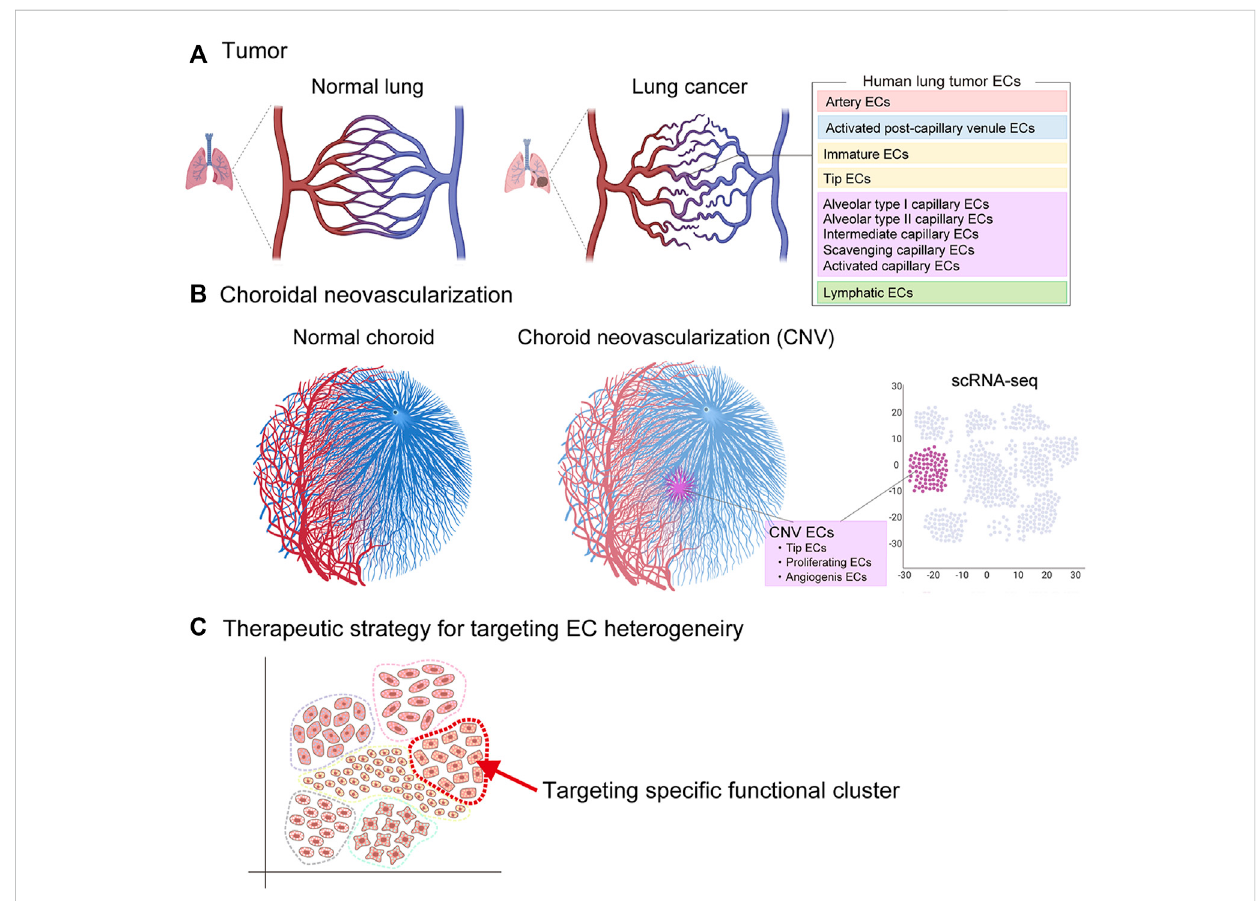
FIGURE 8 Vascular endothelial cell heterogeneity in pathological angiogenesis. Vascular endothelial heterogeneity exists within pathological vessels seen in (A) tumor (cancer) and (B) choroidal neovascularization (age-related macular degeneration). Potential therapeutic strategy to target endothelial cells responsible for pathological angiogenesis (C)